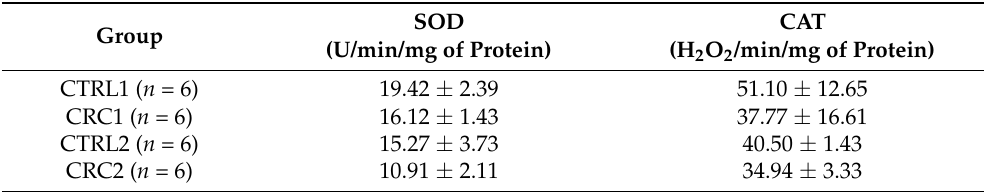
Table 7. Incidence of histopathological proliferative lesions observed in rats’ colon. The percentage represents the number of animals with injury per total number of animals in the group. SOD CAT Group (U/min/mg of Protein) (H 2 O 2 /min/mg of Protein) CTRL1 ( n = 6) 19.42 ± 2.39 51.10 ± 12.65 CRC1 ( n = 6) CTRL2 ( n =